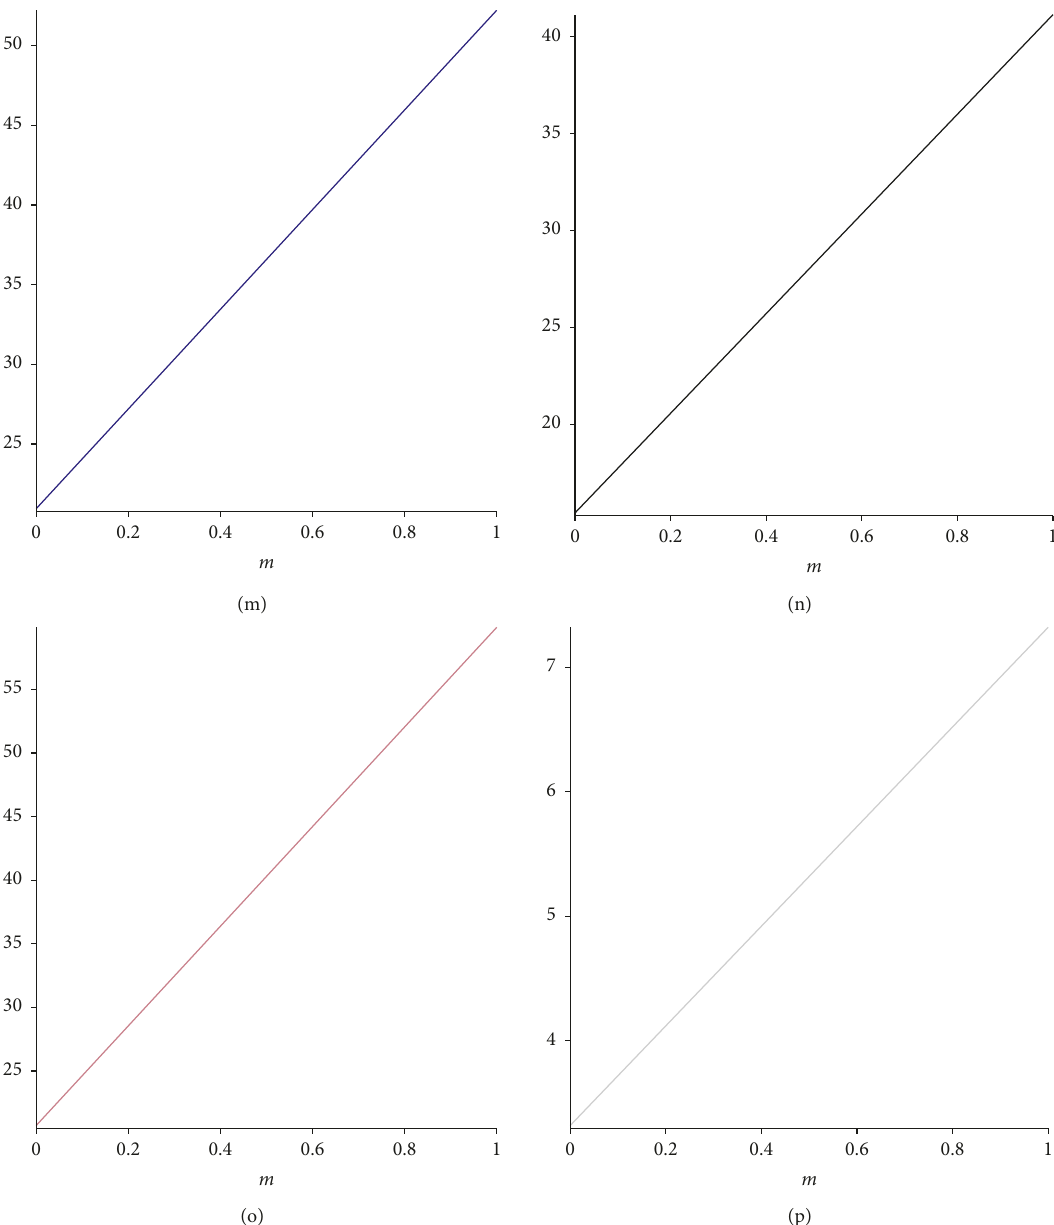
) ; (b) AL ( m − BiI 3 ) ; (i) IRC ( m − BiI 3